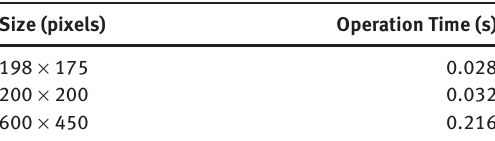
Table 5. SG Operation